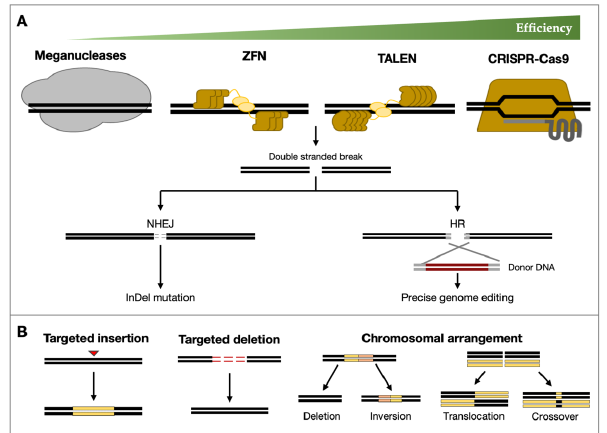
Figure 1. Different types of sequence-specific nucleases and types of editing. ( A ) Meganucleases, zinc finger nuclease (ZFN), transcription activator-like effector nuclease (TALEN), and CRISPR/Cas9 induces double-stranded breaks, which were corrected by non-homologous end-joining (NHEJ) and homologous recombination (HR). ( B ) Schematic diagram of target insertion, target deletion, and chromosomal arrangement through genome editing technologies. InDel, insertion-deletion.